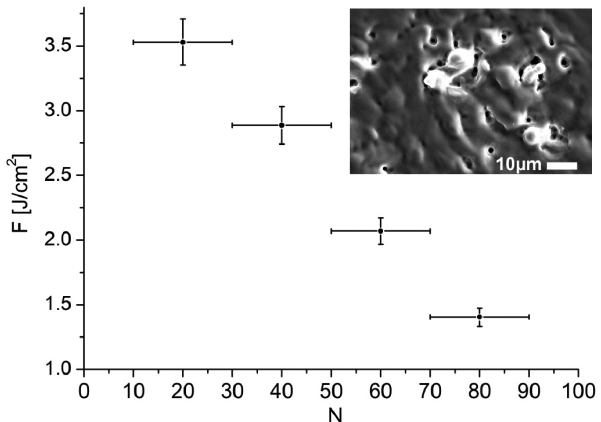
FIG. 2. The threshold for the occurrence of the boiling traces [see Fig. 1(b)] in dependence of the number of pulses, N , and laser fluence F . The inset shows a SEM micrograph of pinholes, which appear in the illuminated area for the corresponding values of N and F ; here F ¼ 1 . 4 J = cm 2 and N ¼ 120 .